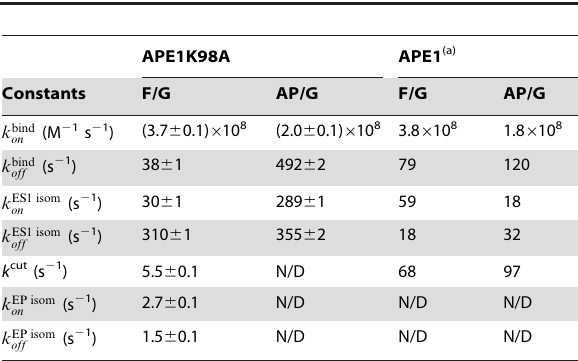
Table 2. Rate constants of APE1K98A and APE1 interactions with specific F- and AP-substrates in BER buffer.